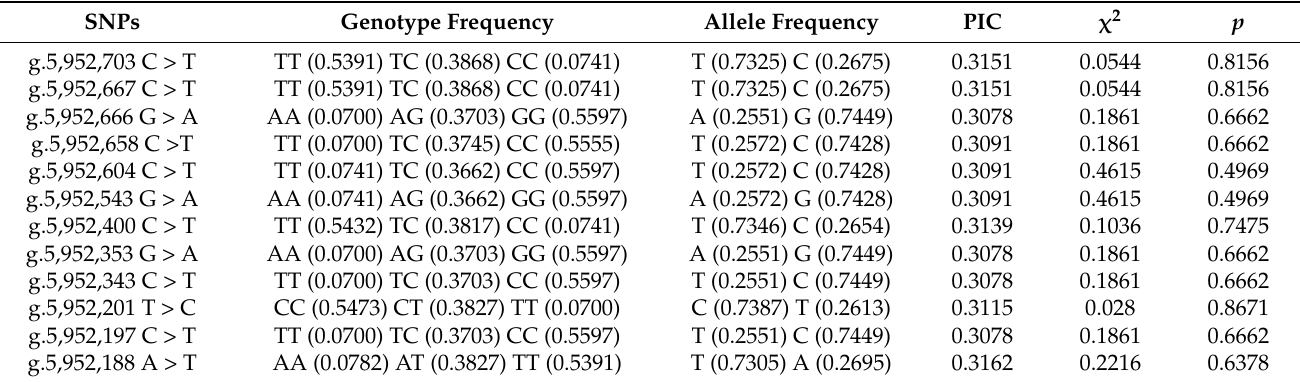
Table 1. Single nucleotide genetic polymorphism analysis of the RXRA gene.